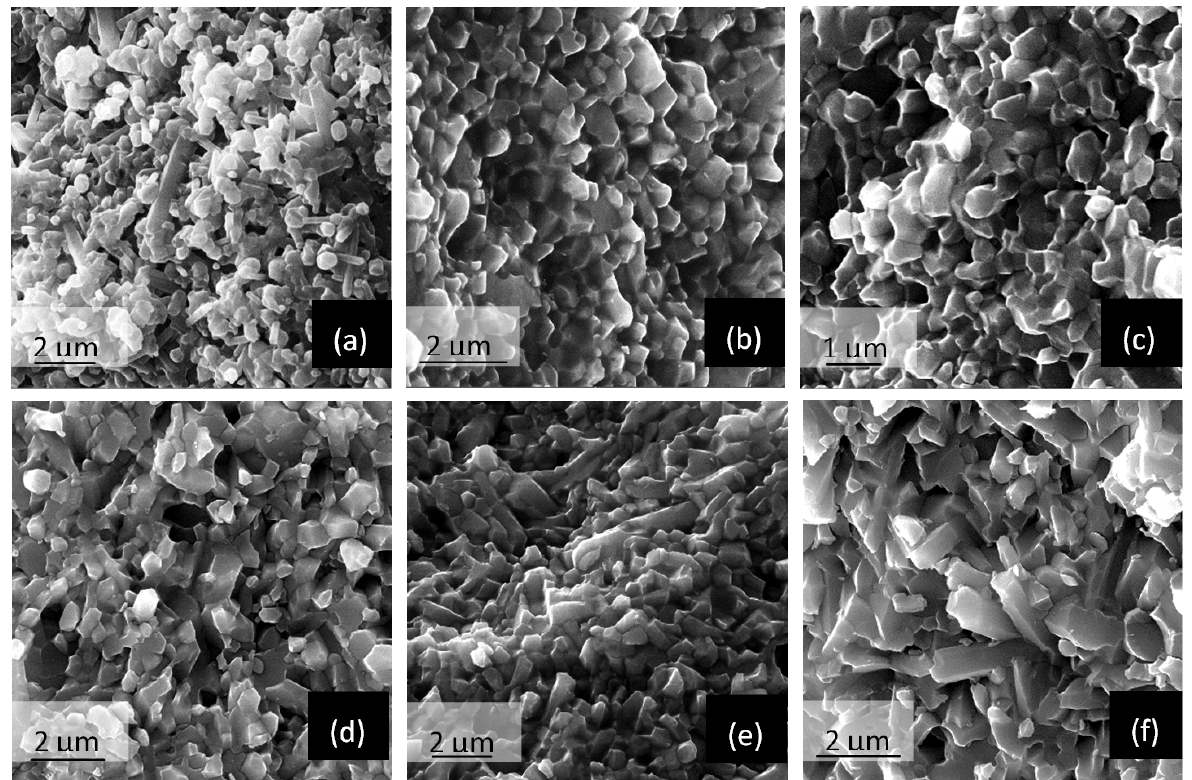
Fig. 7 Secondary electron (FESEM) micrographs of the fractured surfaces of nitrogen rich samples synthesized at 1500 ℃ using different x values: (a) Ca-0.2, (b) Ca-0.6, (c) Ca-1.2, (d) Ca-1.6, (e) Ca-1.8, and (f)